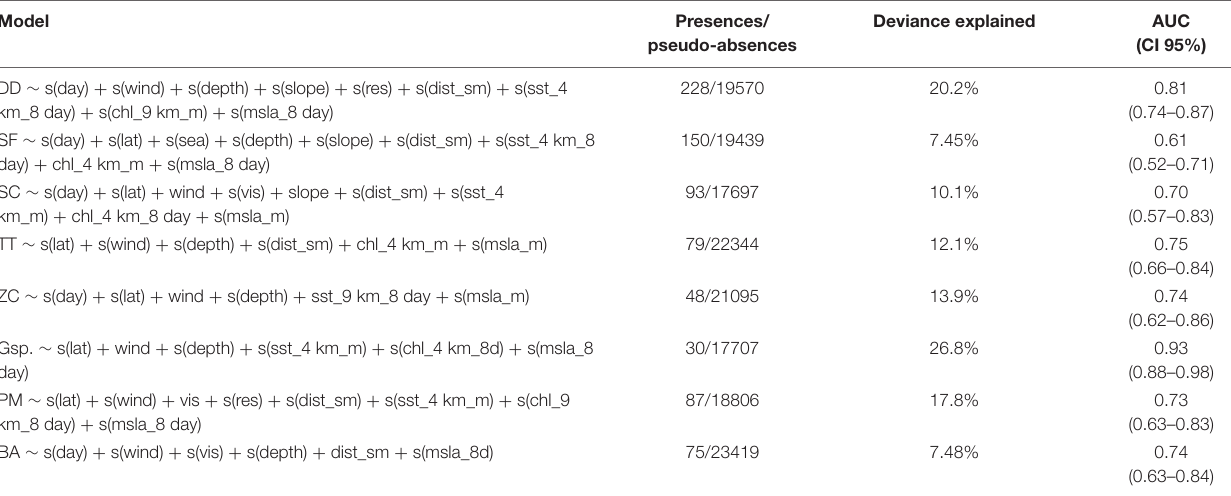
TABLE 1 | Results from the best final GAM models developed for the eight most frequently sighted species.